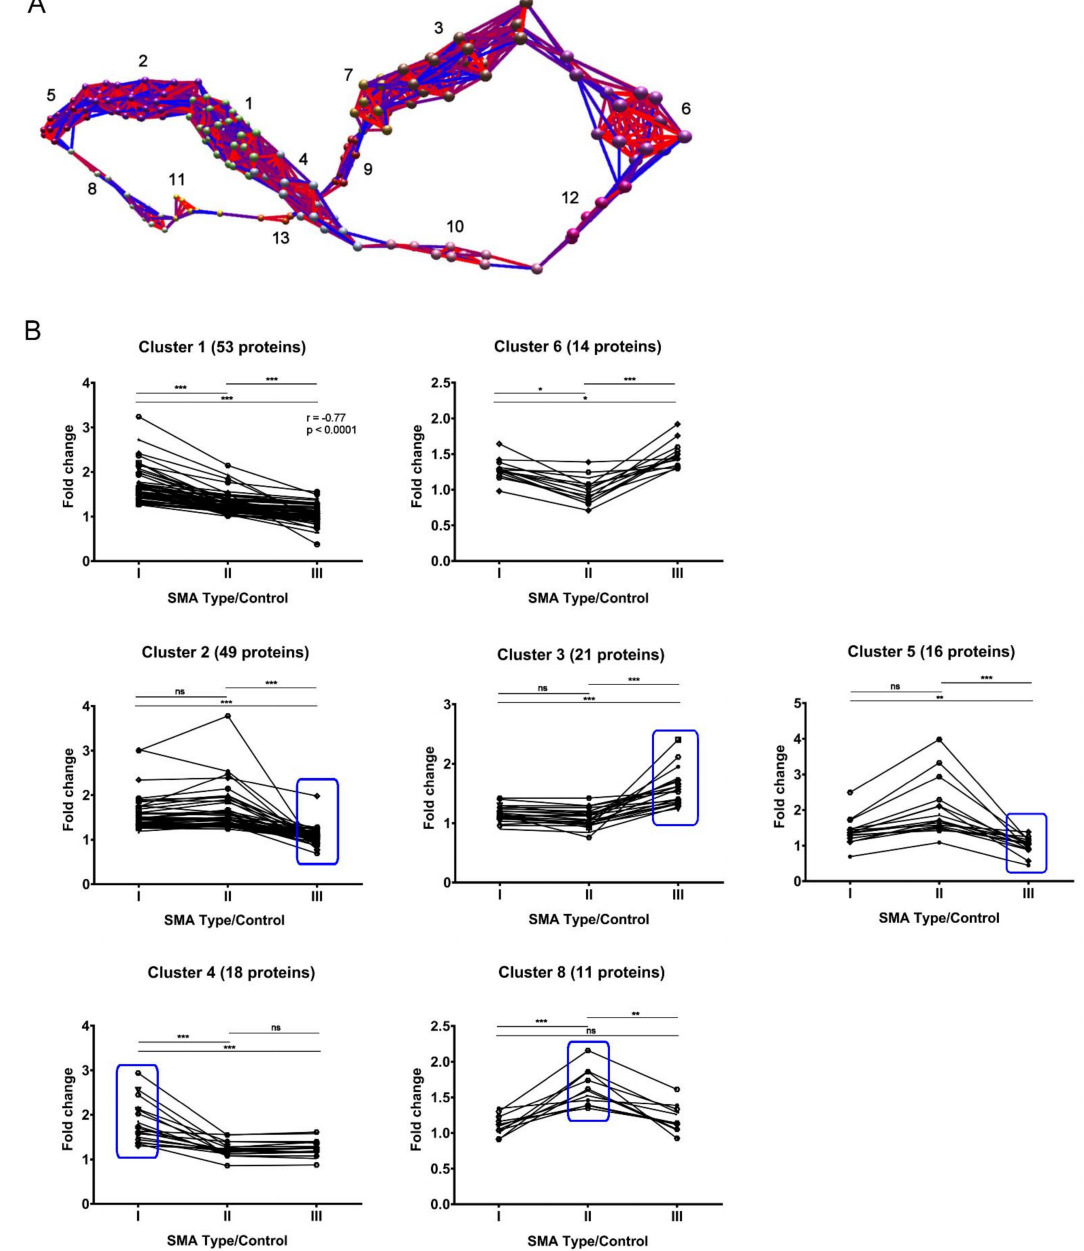
Figure 4. Output following BioLayout Express 3D software analysis of proteins that met the